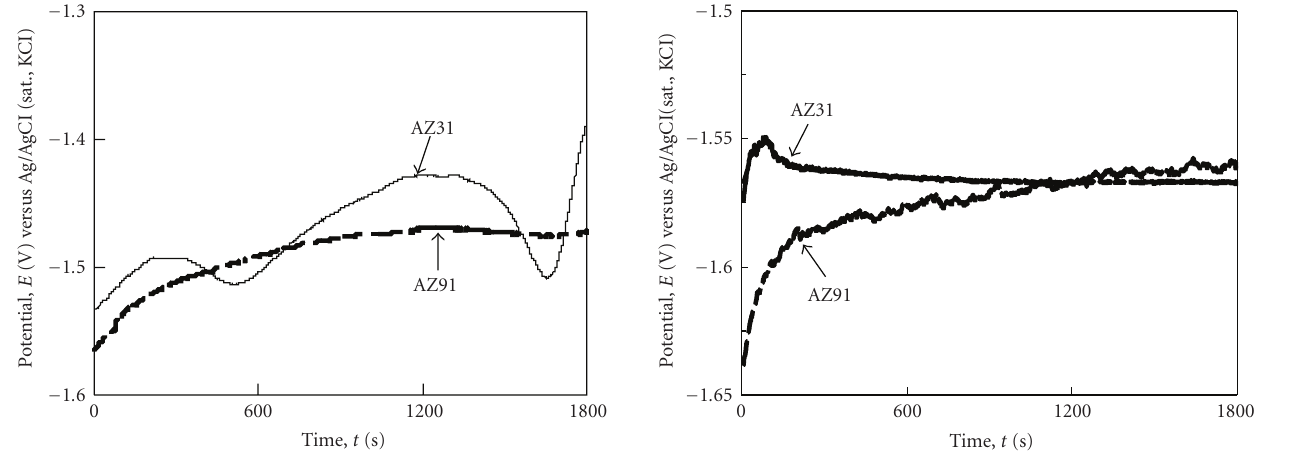
Figure 2: OCP of AZ31 and AZ91 magnesium alloys in 1 MNaOH solution.